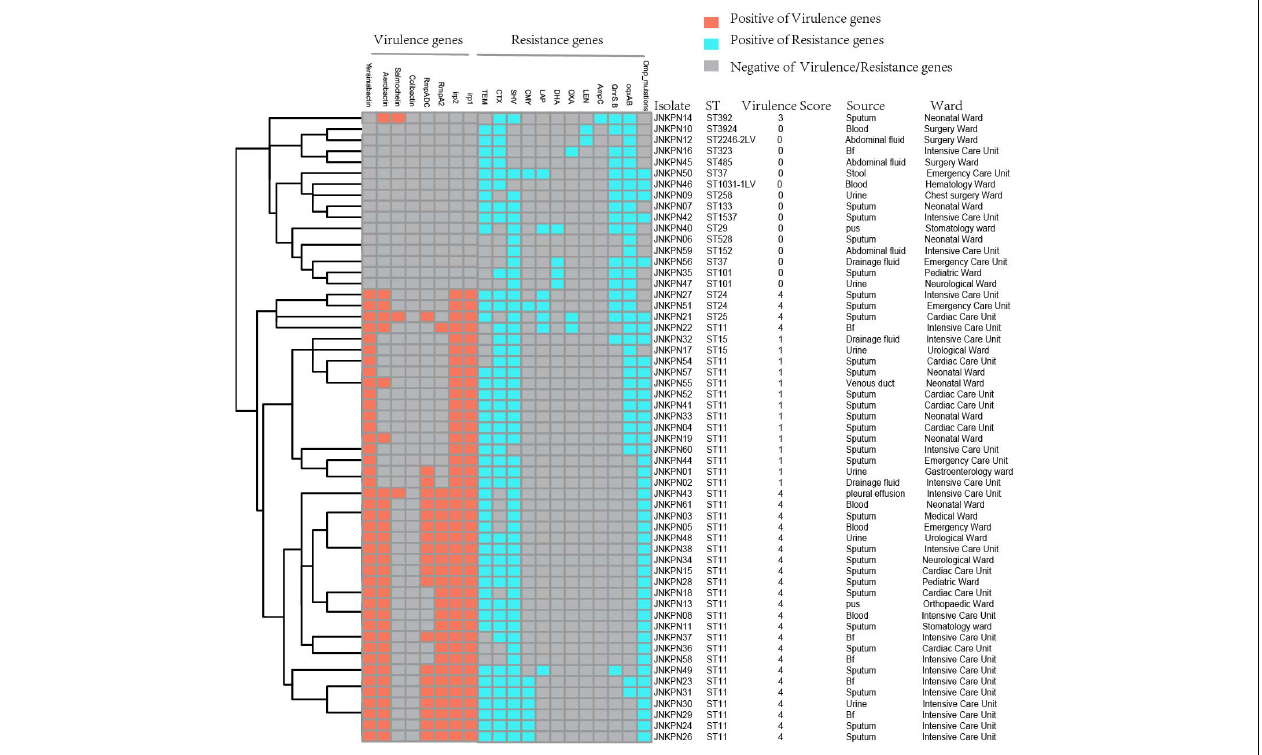
FIGURE 4 | Detection of resistance genes and virulence genes in carbapenem-resistant Klebsiella pneumoniae (CRKP) isolates. The sequence type, virulence score, source, and ward of each isolate were marked on the right of the squares. Bf, bronchoalveolar lavage fluids.